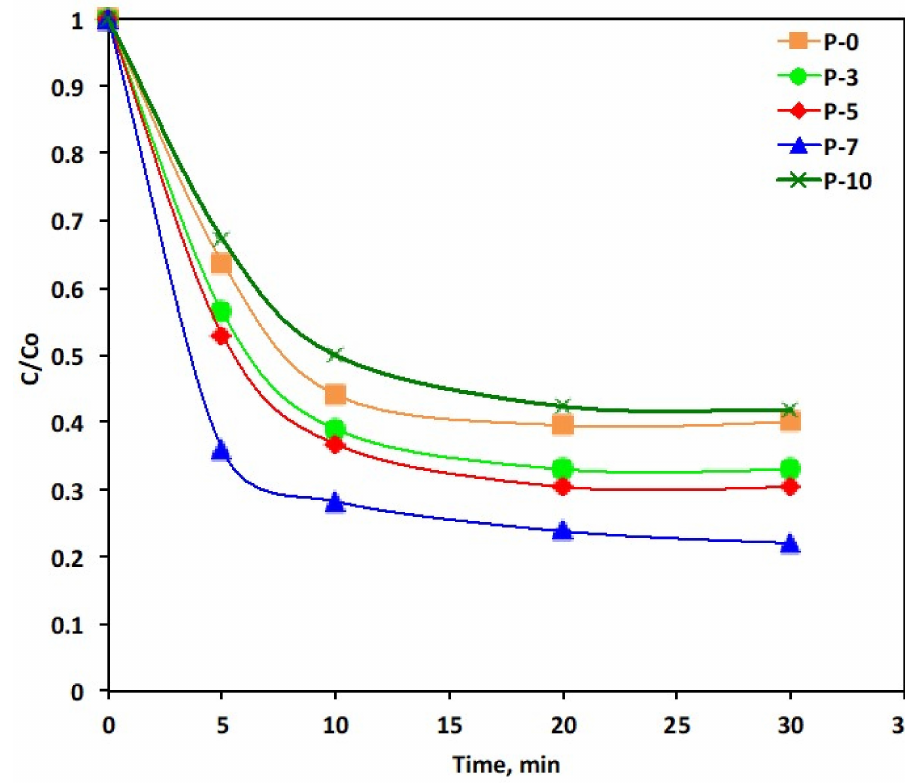
Figure 8. Effect of the different wt% composites and PANI-MWCNTs systems on the Reactive Blue 4 oxidation (Experimental conditions: Reactive Blue 4 = 10 ppm; PANI-MWCNTs: P-5 = 10